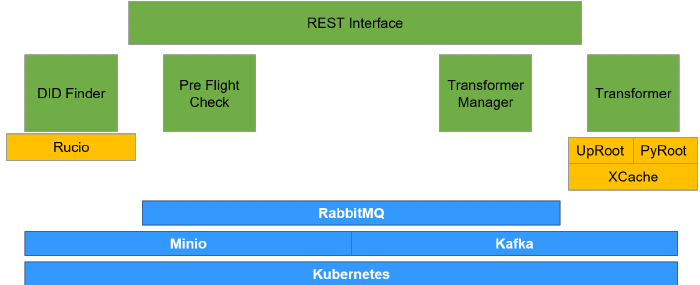
Figure 2. Architecture for ServiceX version